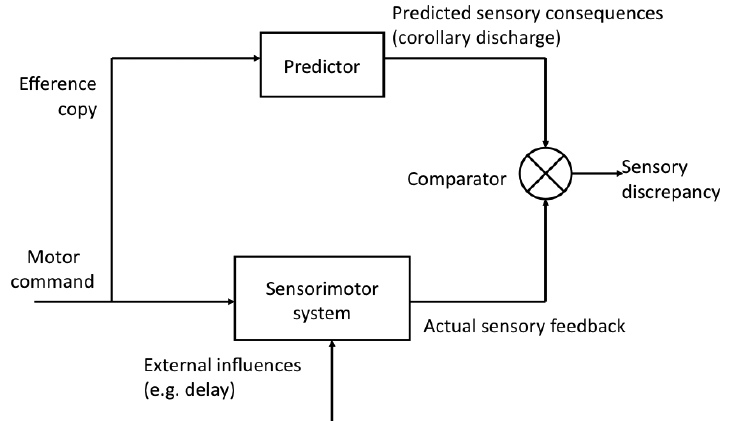
Fig. 1. A simple model of the motor system adapted from Frith et al. [3]. Actual and predicted sensory information are compared to generate a sensory discrepancy which signals movement error. trol patients without AHP (nonAHP, n = 7) and